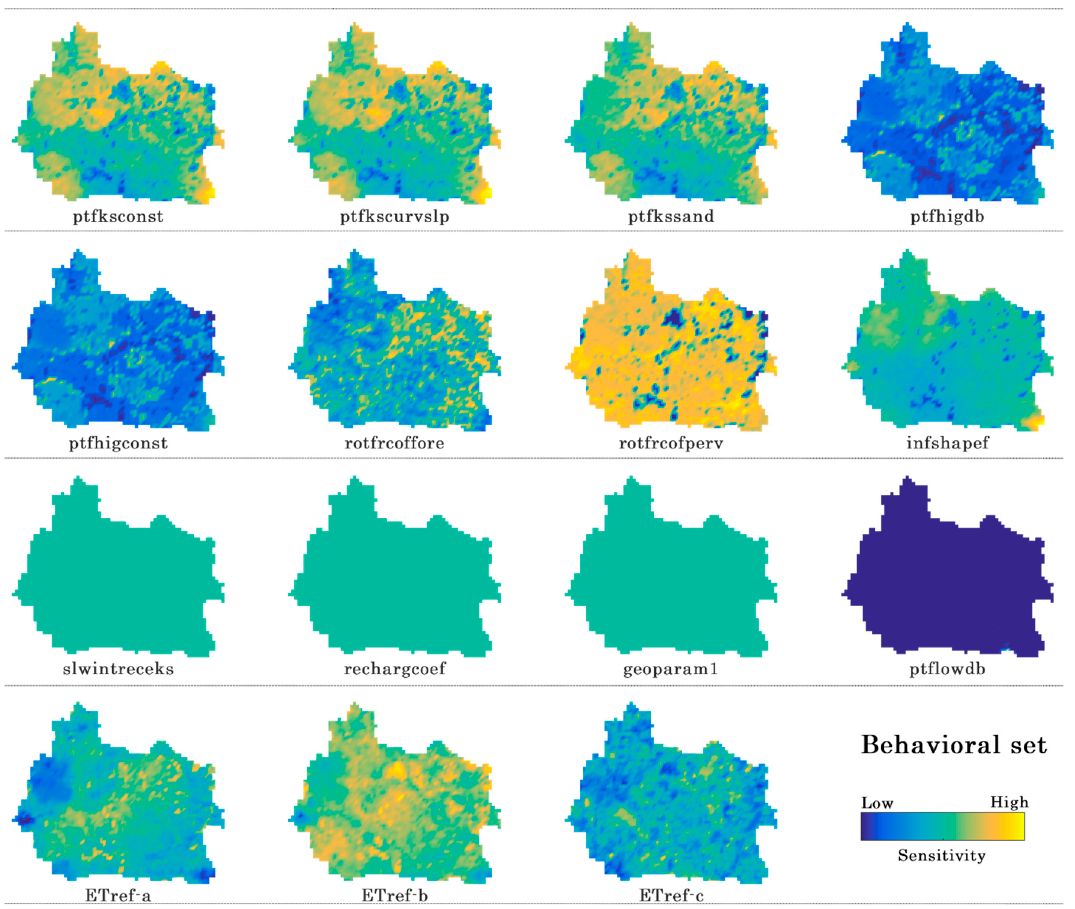
Figure 4. Average of 100 sensitivity maps (entire Skjern Basin) based on the difference between 100 behavioral (NSE > 0.5) initial parameter sets and one-at-a-time parameter perturbations (100 runs per